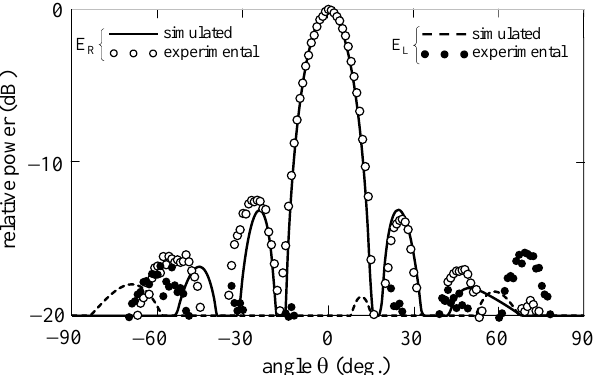
Figure 8. Radiation pattern in φ = 0° plane for a modified branched line antenna with N = 4. Solid lines in Figure 9 show the simulated frequency responses of the gain, axial ratio, and VSWR. It is found that a CP wave bandwidth for a 3 dB axial-ratio criterion is 2.5%, where the gain is almost constant with a VSWR of less than 2. For reference, the gain and axial ratio of the original antenna are also shown with dotted lines. The CP wave bandwidth is almost the same as that of the modified antenna. It can be said that the modified antenna has a gain enhancement of 2.0 dB without deterioration in the CP wave bandwidth of the original antenna.